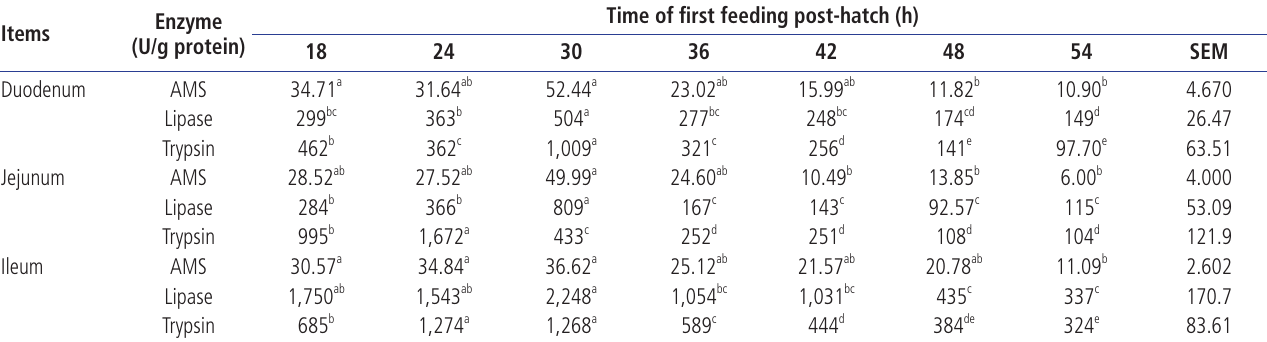
Time of first feeding post-hatch